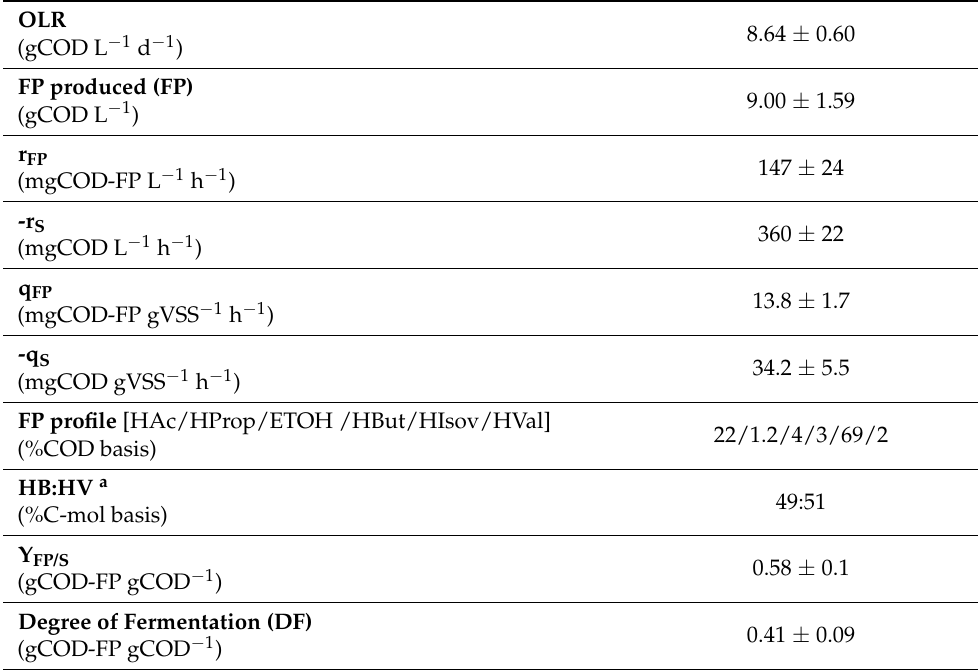
Table 5. EGSB performance in the last 10 days of operation (between days 20 and 29 of